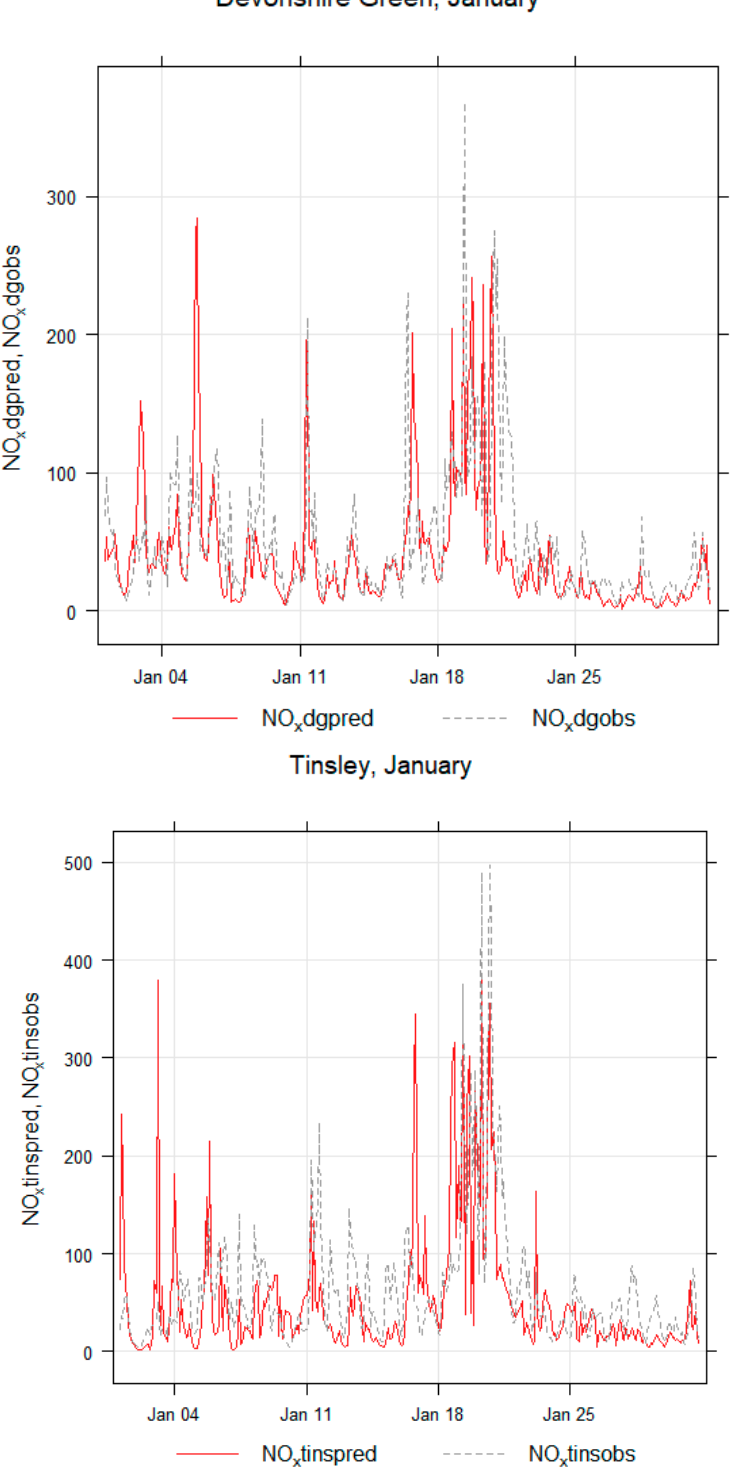
Figure 9. Comparison of predicted (pred) and observed (obs) NOx at both Devonshire Green (dg) and Sheffield Tinsley (tins) for the month of January 2017. Table 5. The value of various statistical metrics used for assessing the performance of the model for predicting NOx concentrations in the month of January 2017 at both Devonshire Green and Sheffield Tinsley.